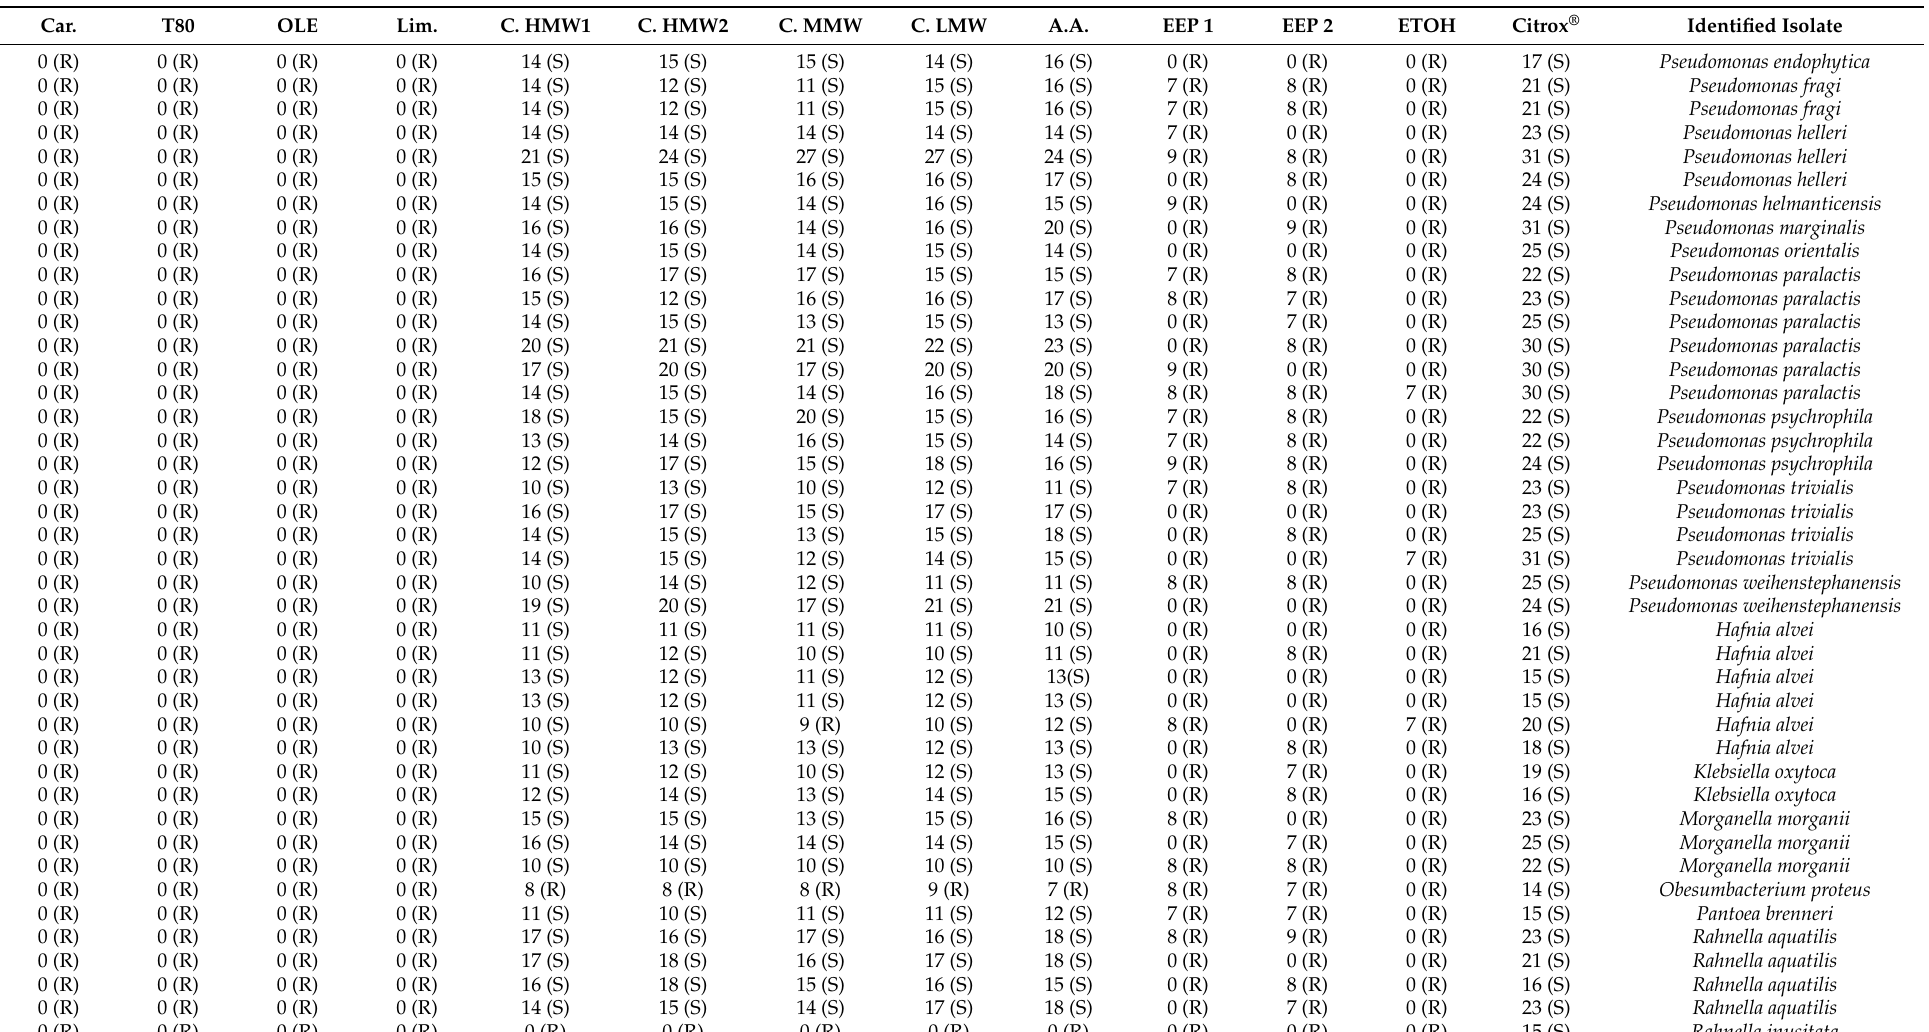
Table 4. Diameters of inhibition halos (mm) and susceptibility obtained for each compound against each identified isolate.